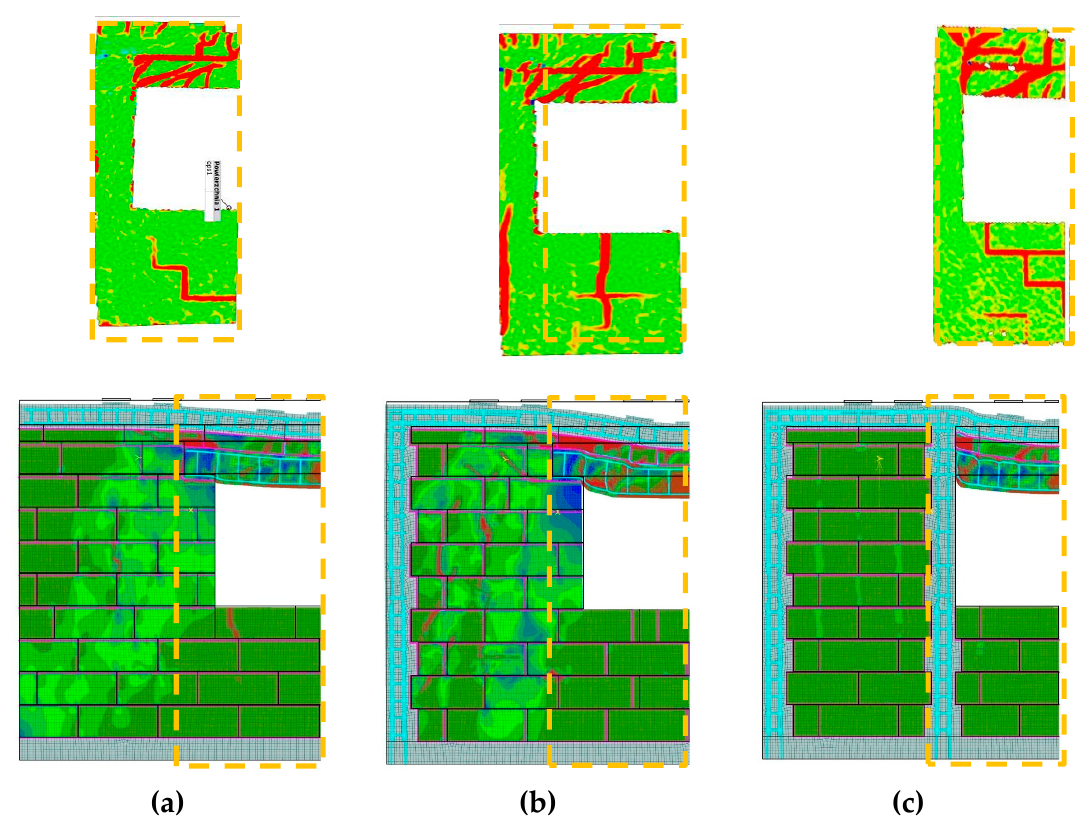
Figure 20. Comparison of damage recorded by the optical system and the deformation in the numerical model of the walls of series: ( a ) MNSO, ( b ) MSO, ( c ) M2SO. Results of the numerical analysis were compared with mean values of destructive force and deflection obtained for each series of the tested models. For the model MNSO, the maximum destructive force acting on the lintel was 210 kN, and the deflection was 11.7 mm. The obtained destructive force was greater by 9% than the force obtained during the tests, and the value of deflection constituted 36% of the experimentally obtained deflection. For the numerical model MSO, the obtained destructive force of 215 kN was equal to the test force, and the deflection of 24.1 mm was greater by 84% than the corresponding deflection obtained during the laboratory tests. Similar discrepancies between the results from the numerical analysis and laboratory tests were observed for the model M2SO. The destructive force of 255 kN was smaller by 4%, and the deflection of 23.4 mm was greater by 200% than the corresponding destructive force and deflection obtained during the laboratory tests. Figure